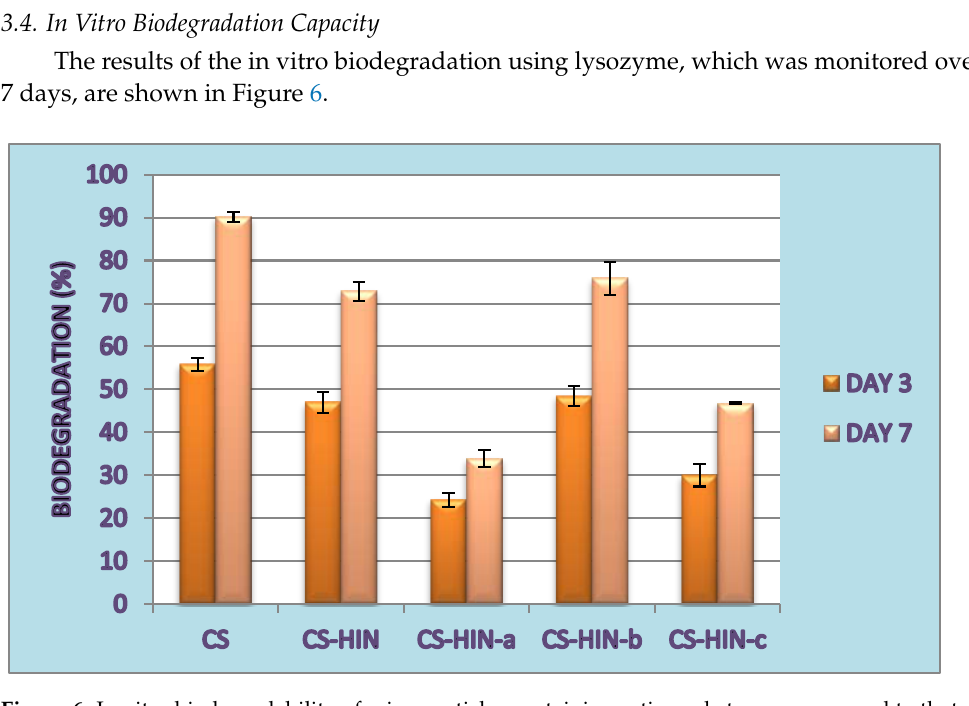
Figure 6. In vitro biodegradability of microparticles containing active substances compared to that of empty microparticles